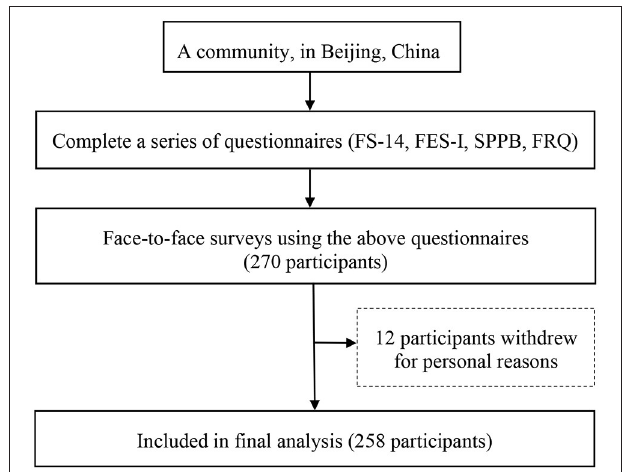
FIGURE 2 | Flow chart of survey